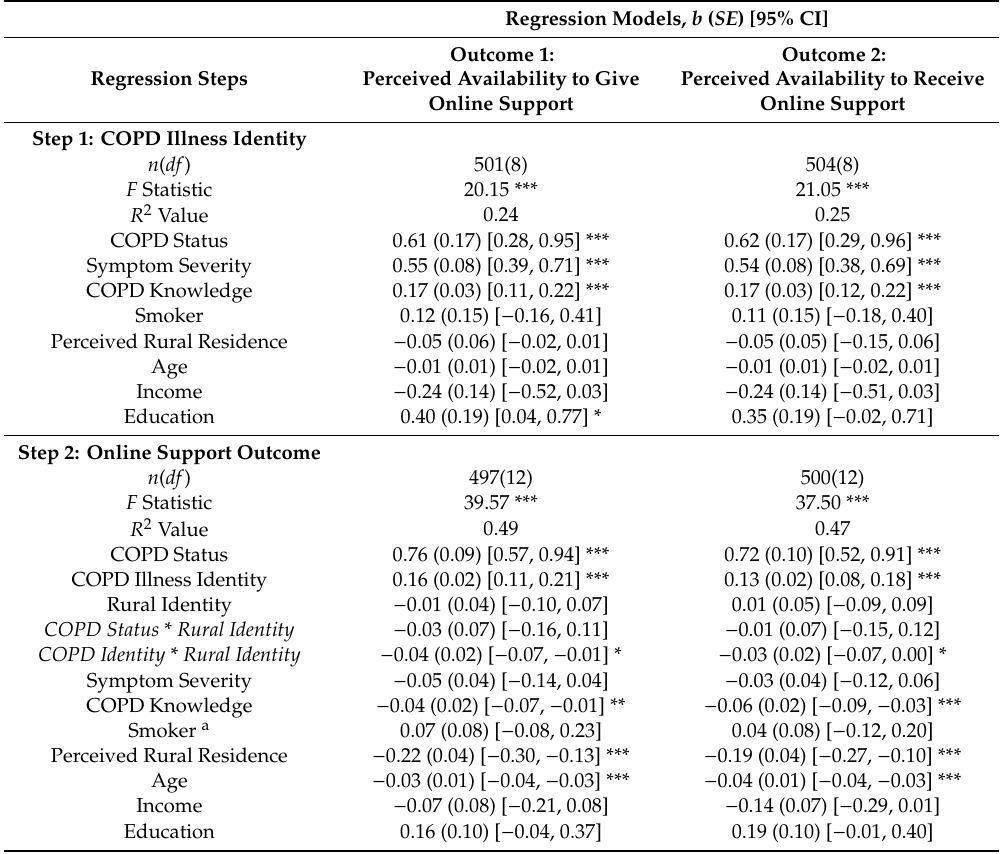
Table 3. Conditional process analyses of identity on online health-related engagement.